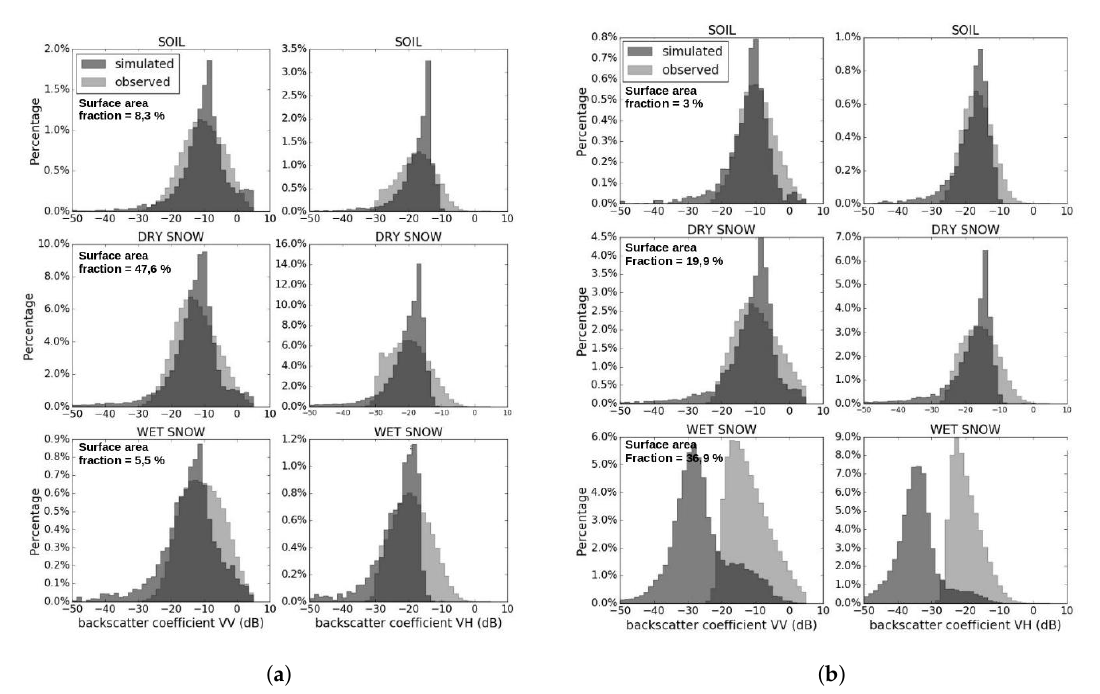
Figure 6. Distributions of the backscatter signal simulated (dark grey) and observed (light grey) extracted from the pixels of our study area for three types of surface according to Crocus model output: soil, dry snow and wet snow: ( a ) 10 December 2015/ascending orbit; and ( b ) 1 April 2015/descending orbit. Table 2. Pearson correlation coefficients calculated between observations scenes and simulations for different elevation ranges, orbit type and VV and VH polarization and thus considering the Sentinel-1 data. Ascending Orbit (6 p.m.) Descending Orbit (6 Elevation